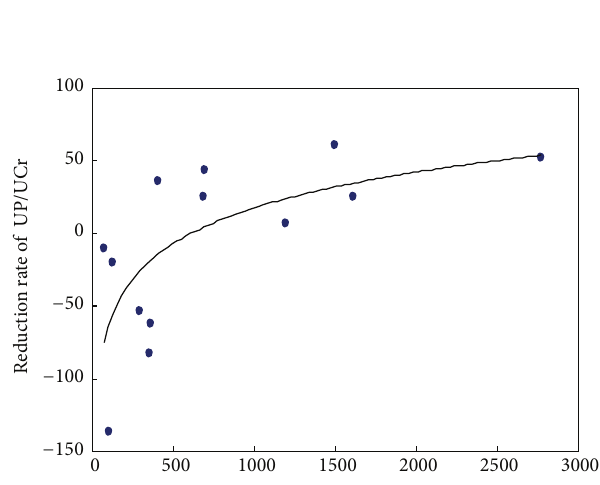
Figure 1: UP/UCre levels.